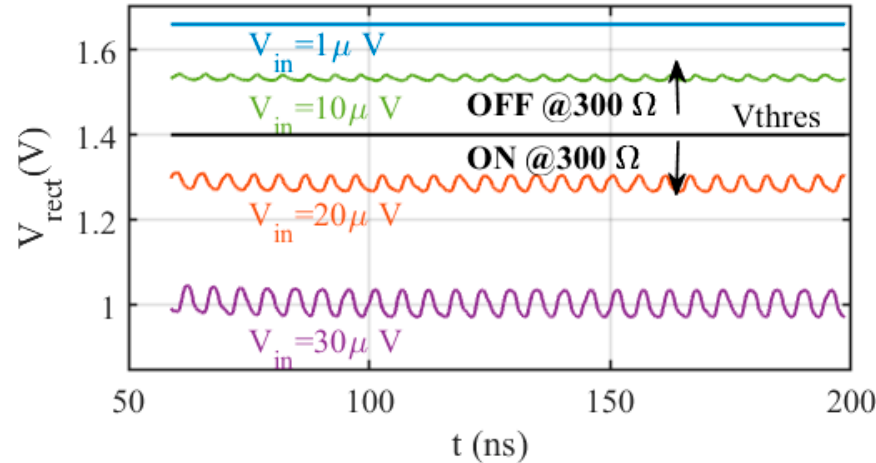
Figure 16. Stand-alone envelope-detector outputs of V in,env = {1, 10, 20, 30} µV.